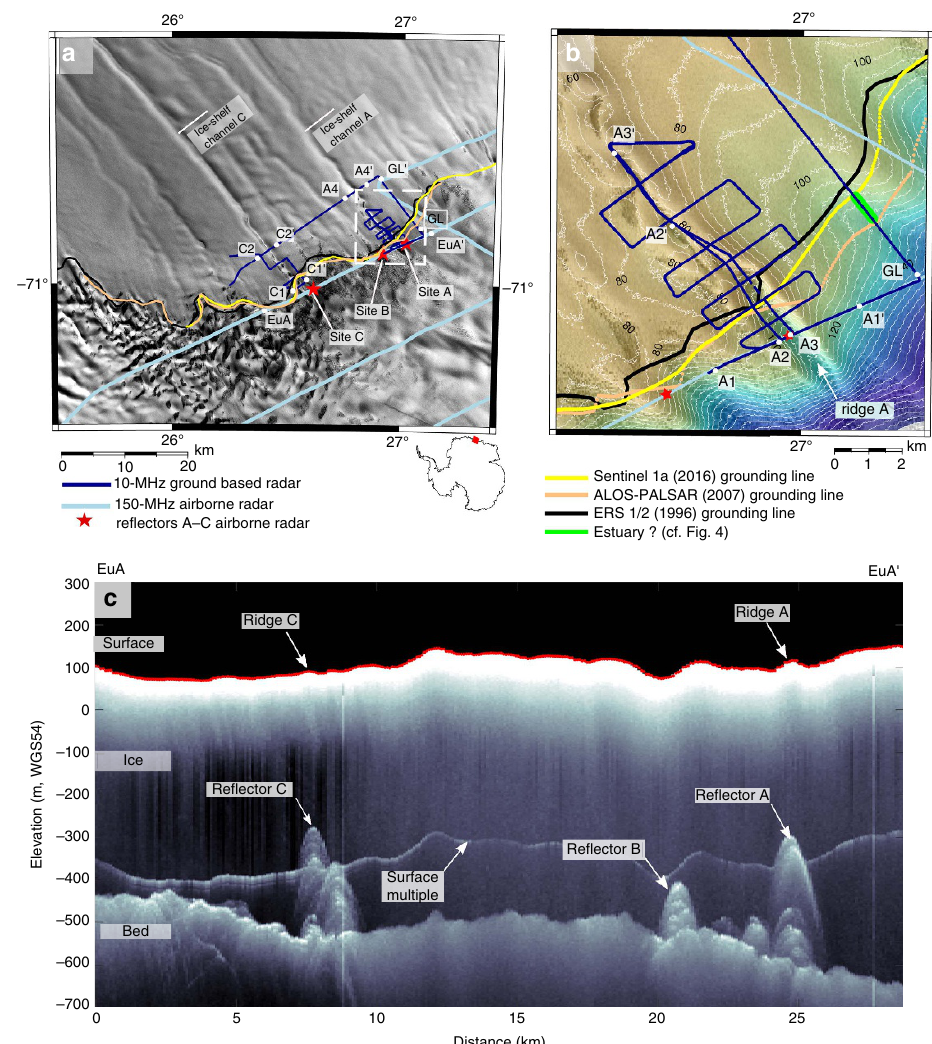
Figure 1 | Overview of the study area. ( a ) Location of airborne (2011) and ground-based (2016) radar profiles of the Roi Baudouin Ice Shelf, East Antartica, with Landsat image in the background. Grounding lines are marked for 1996, 2007 and 2016. The dashed white box delineates the area in b where radar-profile locations are shown with TanDEM-X surface elevation (5m contours). ( c ) Airborne radar profile EuA-EuA 0 covering the grounded ice sheet. Internal reflection hyperbolas reaching hundreds of metres above the ice-bed interface are evident (reflectors A–C), and are aligned with ice-shelf channels located seawards (into page). Reflectors A and C are beneath surface